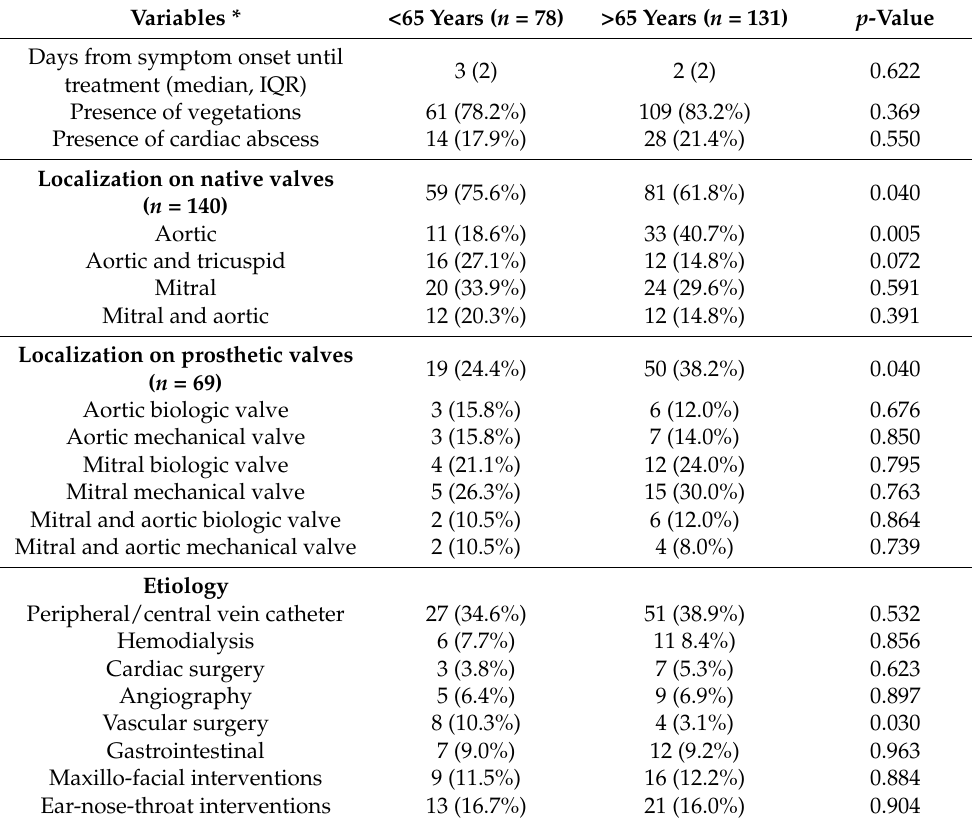
Table 2. Endocarditis features of the patients included in the